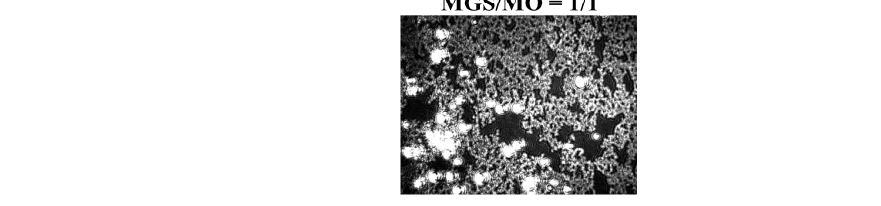
Figure 3. BAM micrographs of MGS and MGS/CN layers at constant amount of MGS and at fixed total lipid. BAM micrographs intensity of CN containing films was attenuated for better visual perception. (The bottom image shows the lack of spreading of MO in pseudobinary films with MGS.) (Field of view is 3000 µm × 3000 µm).